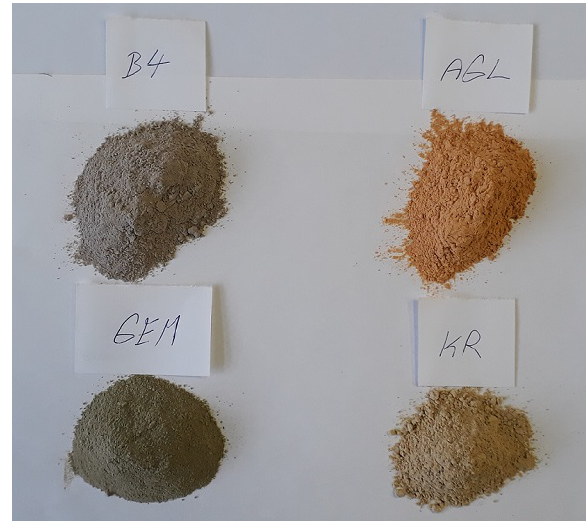
Figure 8. Four kinds of tested